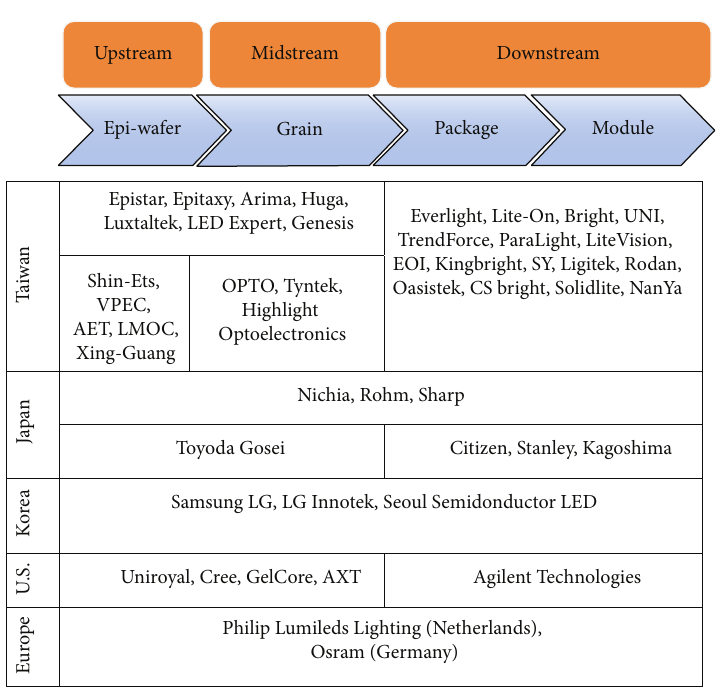
Figure 2: Value chain of global LED industry. Source: this